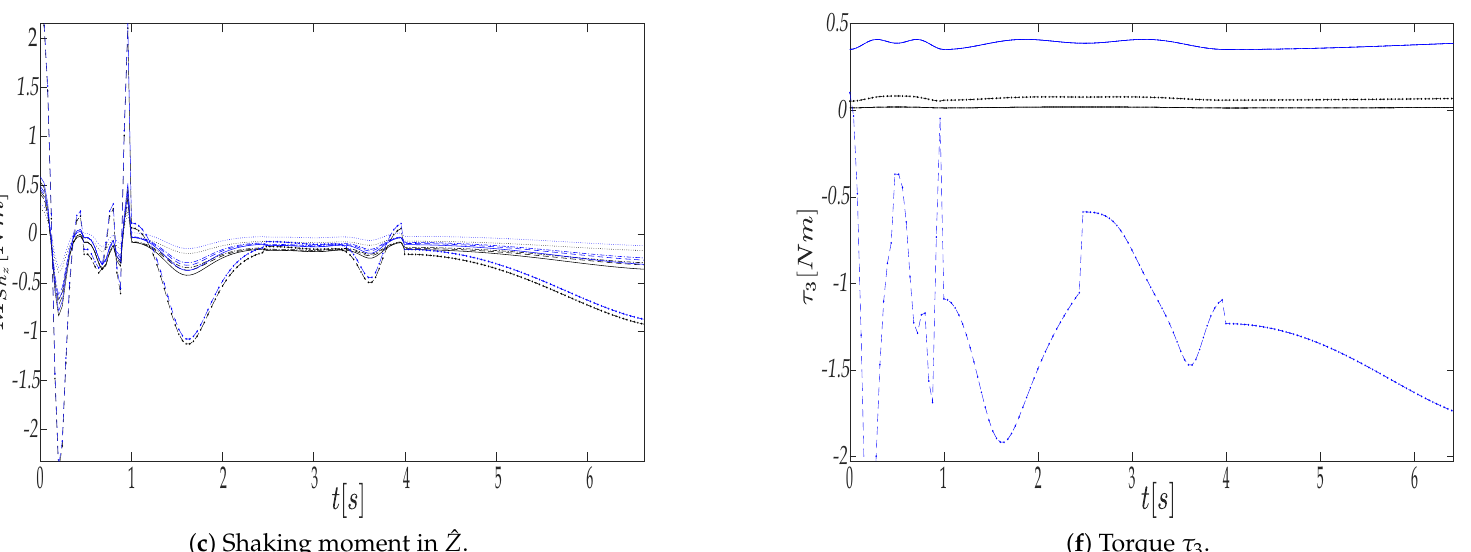
Figure 9. Behavior of the shaking force F Sh , shaking moment M Sh , and torque τ for the designs with different velocities and two different end-effector masses in the z linear trajectory. The design behaviors associated with m e = 0 kg are described in lines as RBD, − · − · − DBD, − − −− DTBD, · · · · ·· SMBD, − · − · − SFBD. The design behaviors associated with m e = 0.5 kg are described in lines as RBD, − · − · − DBD, − − −− DTBD, · · · · ·· SMBD, − · − · −